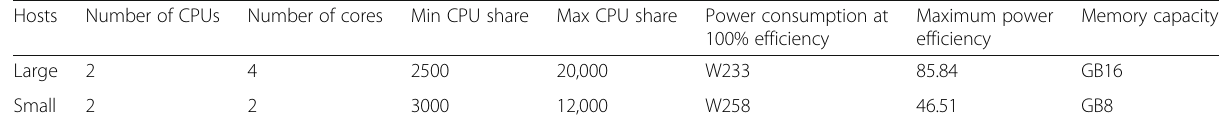
Table 3 The features of hosts used in data